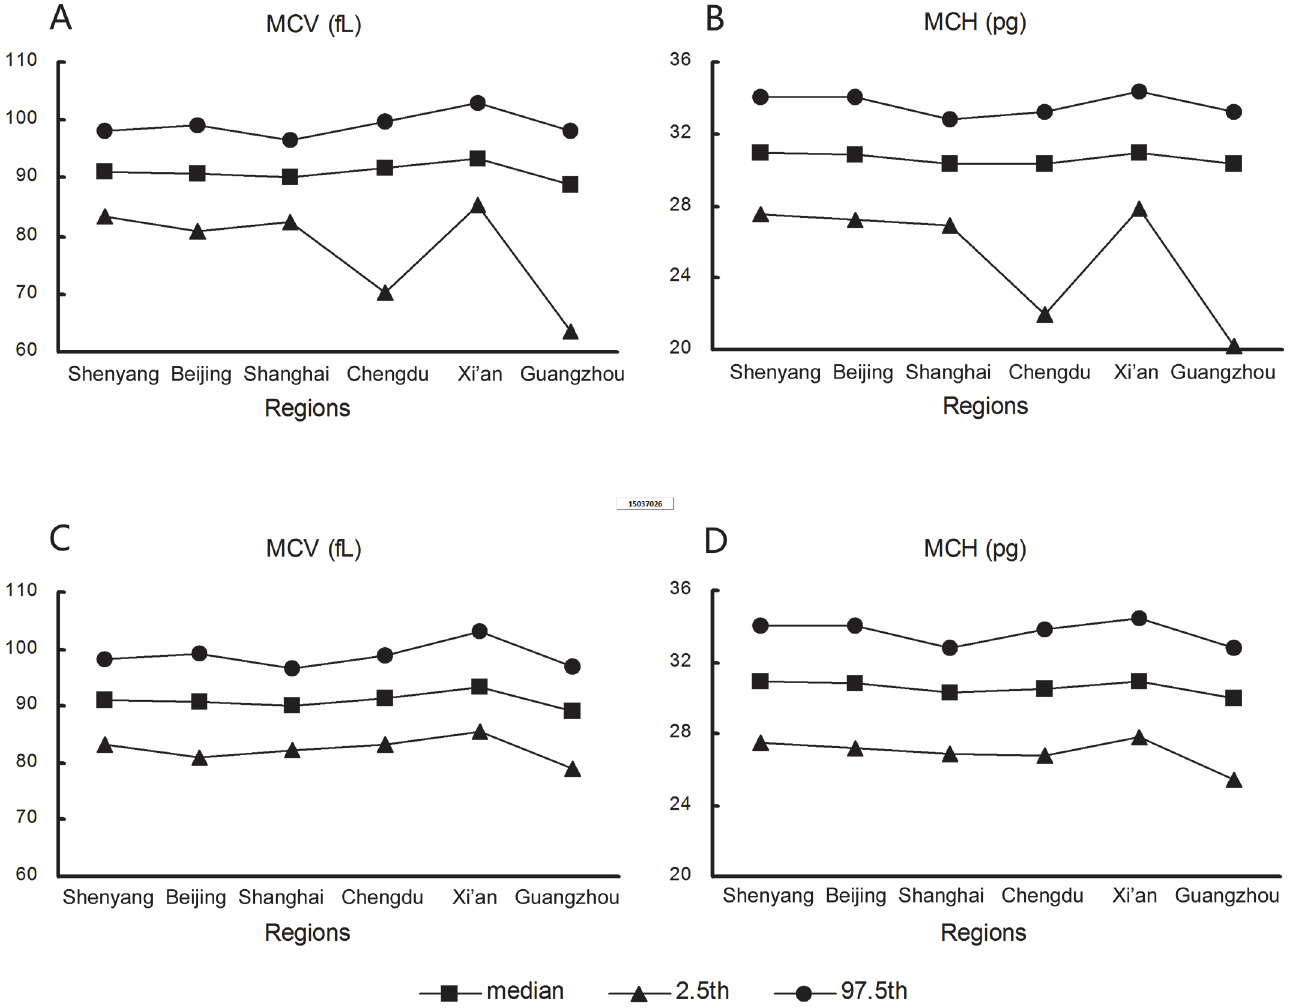
Fig 5. Mean corpuscular volume (MCV) and mean corpuscular hemoglobin (MCH) reference intervals for samples with and without thalassemia trait (TT). Percentiles for (A) MCV with TT, (B) MCH with TT, (C) MCV without TT, (D) MCH without TT according to